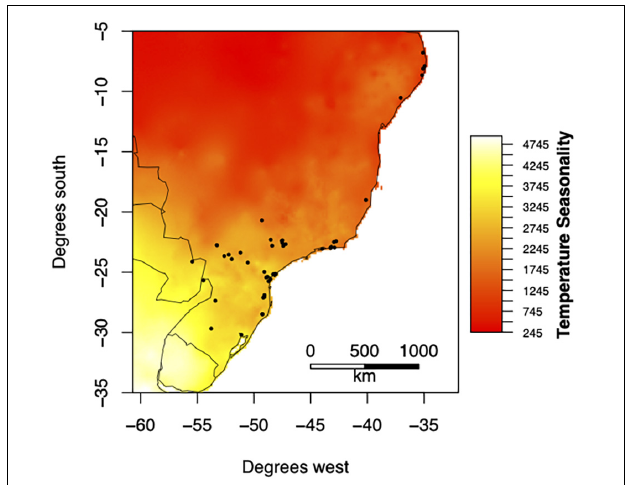
FIGURE 1 | Geographic distribution of temperature seasonality across 49 sites from the ATLANTIC BATS data base (Muylaert et al., 2017). Temperature seasonality (SD X100) was obtained from WorldClim (Fick and Hijmans, 2017). Temperature seasonality, along with other variables of temperature and precipitation, were used to calculate the effect of environmental seasonality, richness, and biomass on community